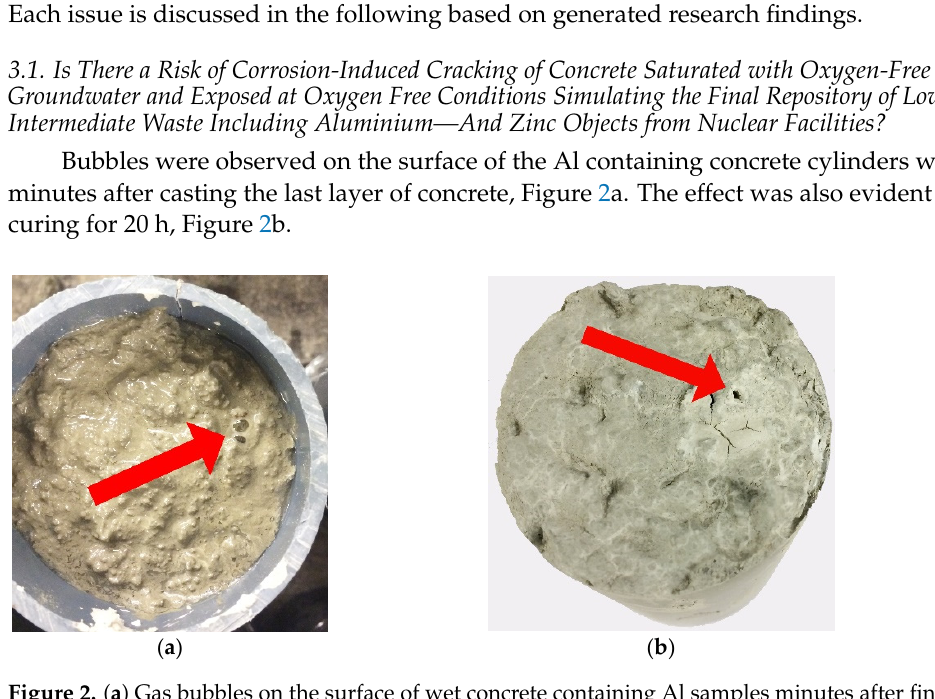
Figure 2. ( a ) Gas bubbles on the surface of wet concrete containing Al samples minutes after finished pouring the concrete into moulds; ( b ) Gas vent outlet on the upper surface of concrete cured for 20 h.